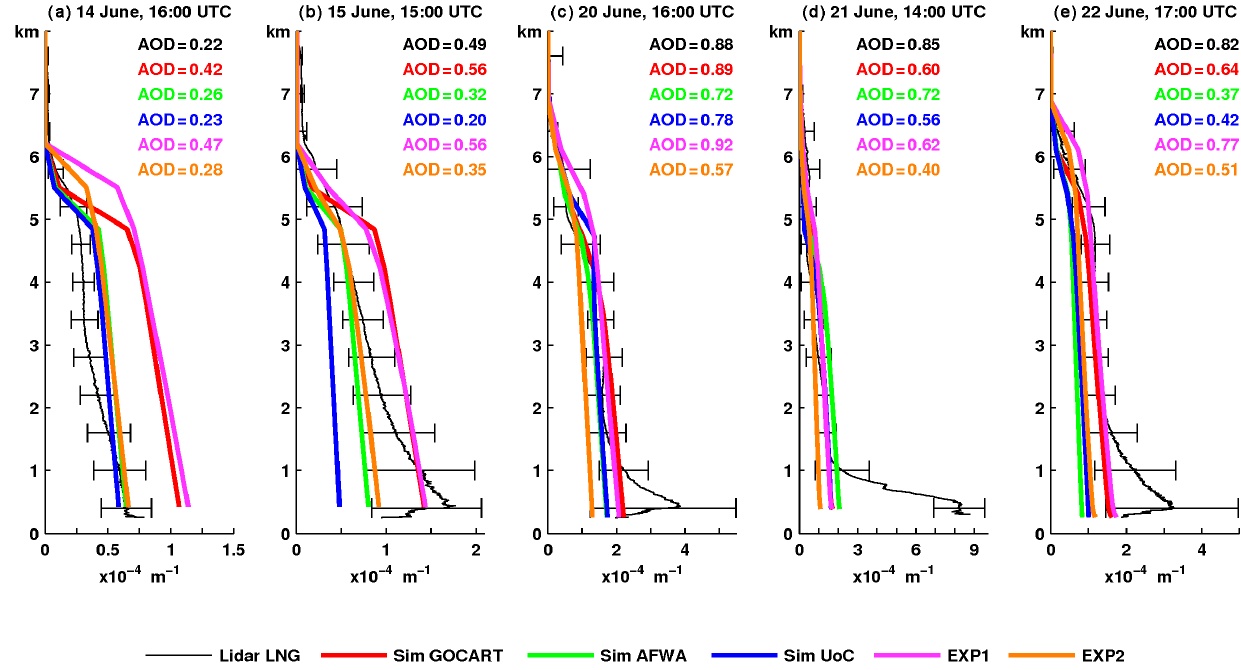
Figure 11. Extinction coefficient vertical profiles from the airborne lidar observations (black solid line) and from the WRF-Chem simulations (see legend for colours). The AOD values corresponding to the profiles are shown within the five panels. Error bar lengths equal twice the SDs of the lidar measurements at a given